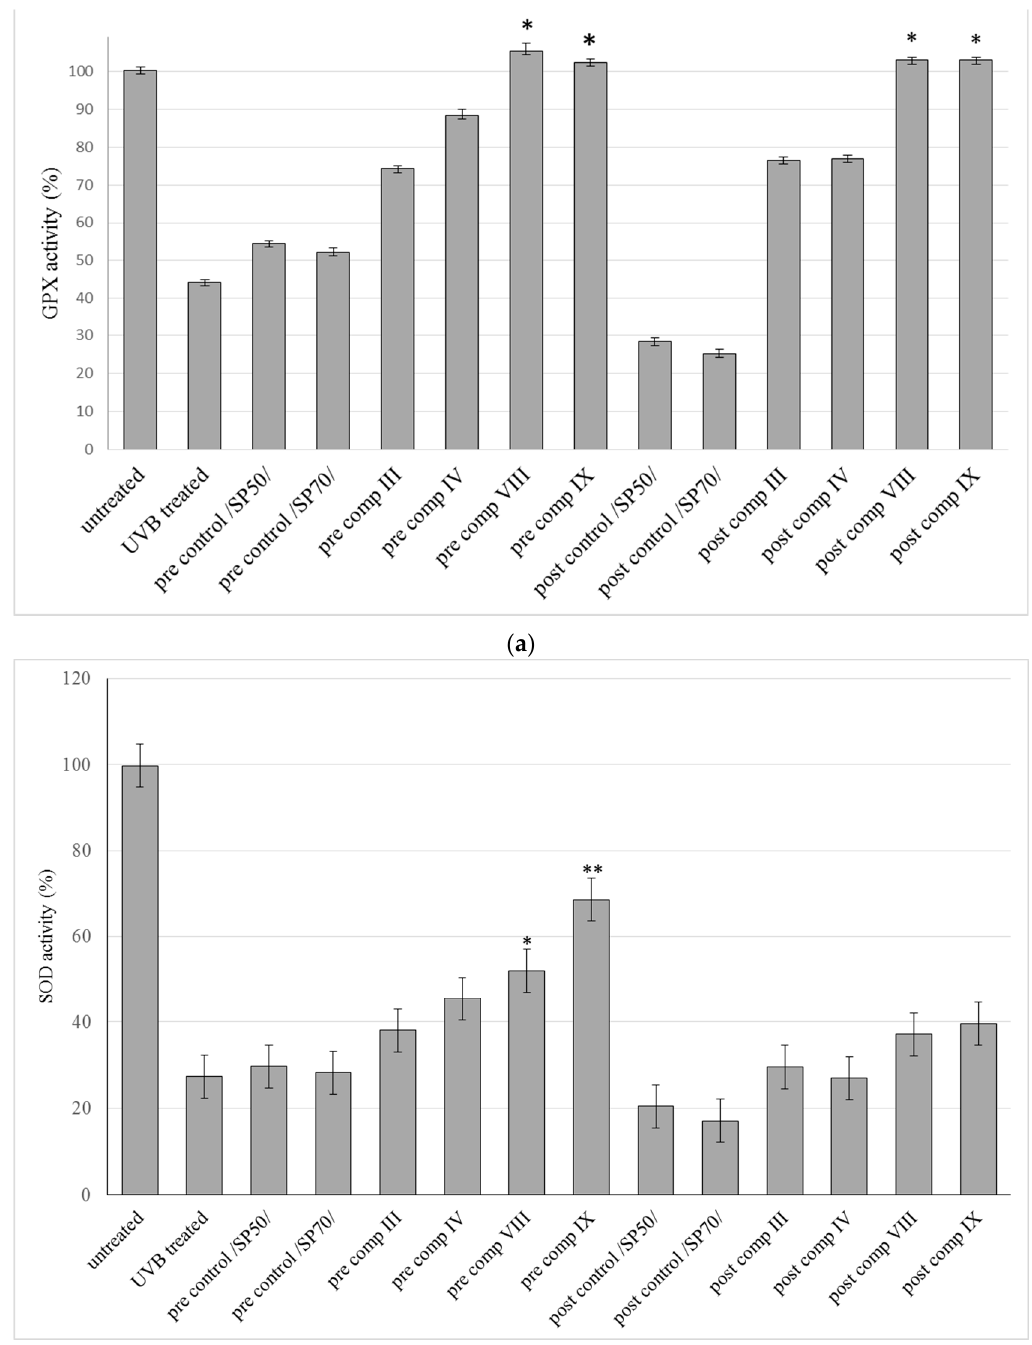
Figure 6. Cont . Figure 6.